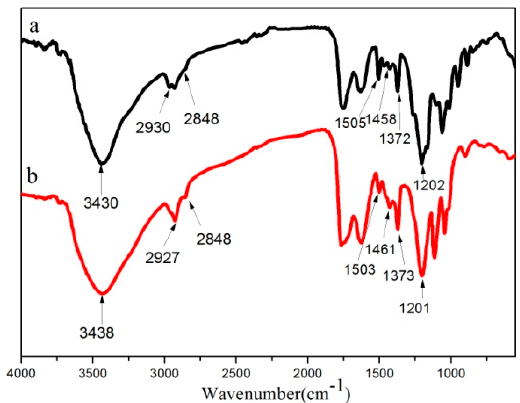
Figure 7. FTIR spectra of WSAL ( a ) and D-WSAL ( b ) prepared under the optimum demethylation condition: 12:1 molar ratio of ICH to lignin, 145 °C, 4 mL DMF, 3 h reaction time under nitrogen atmosphere.